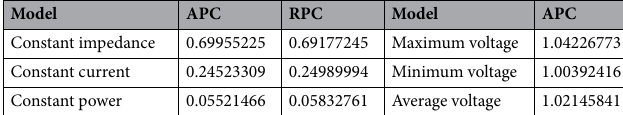
Table 9. Salitral ZIP static load model coefficients and Voltage bus values.